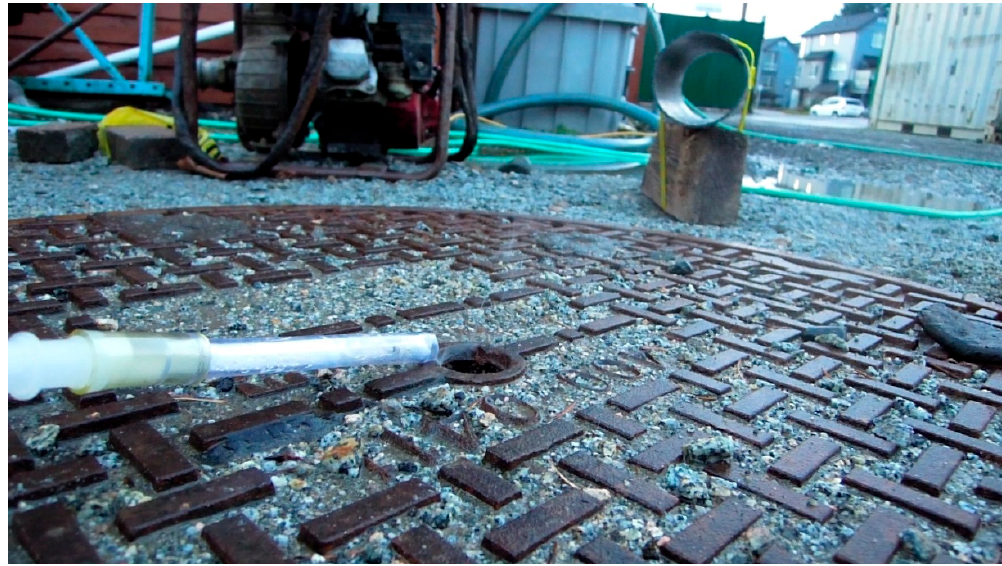
Figure 3. Movement of ‘smoke’ across the opening in the manhole cover. ‘Smoke’ typically did not interact with the atmosphere in the airspace of the structure.